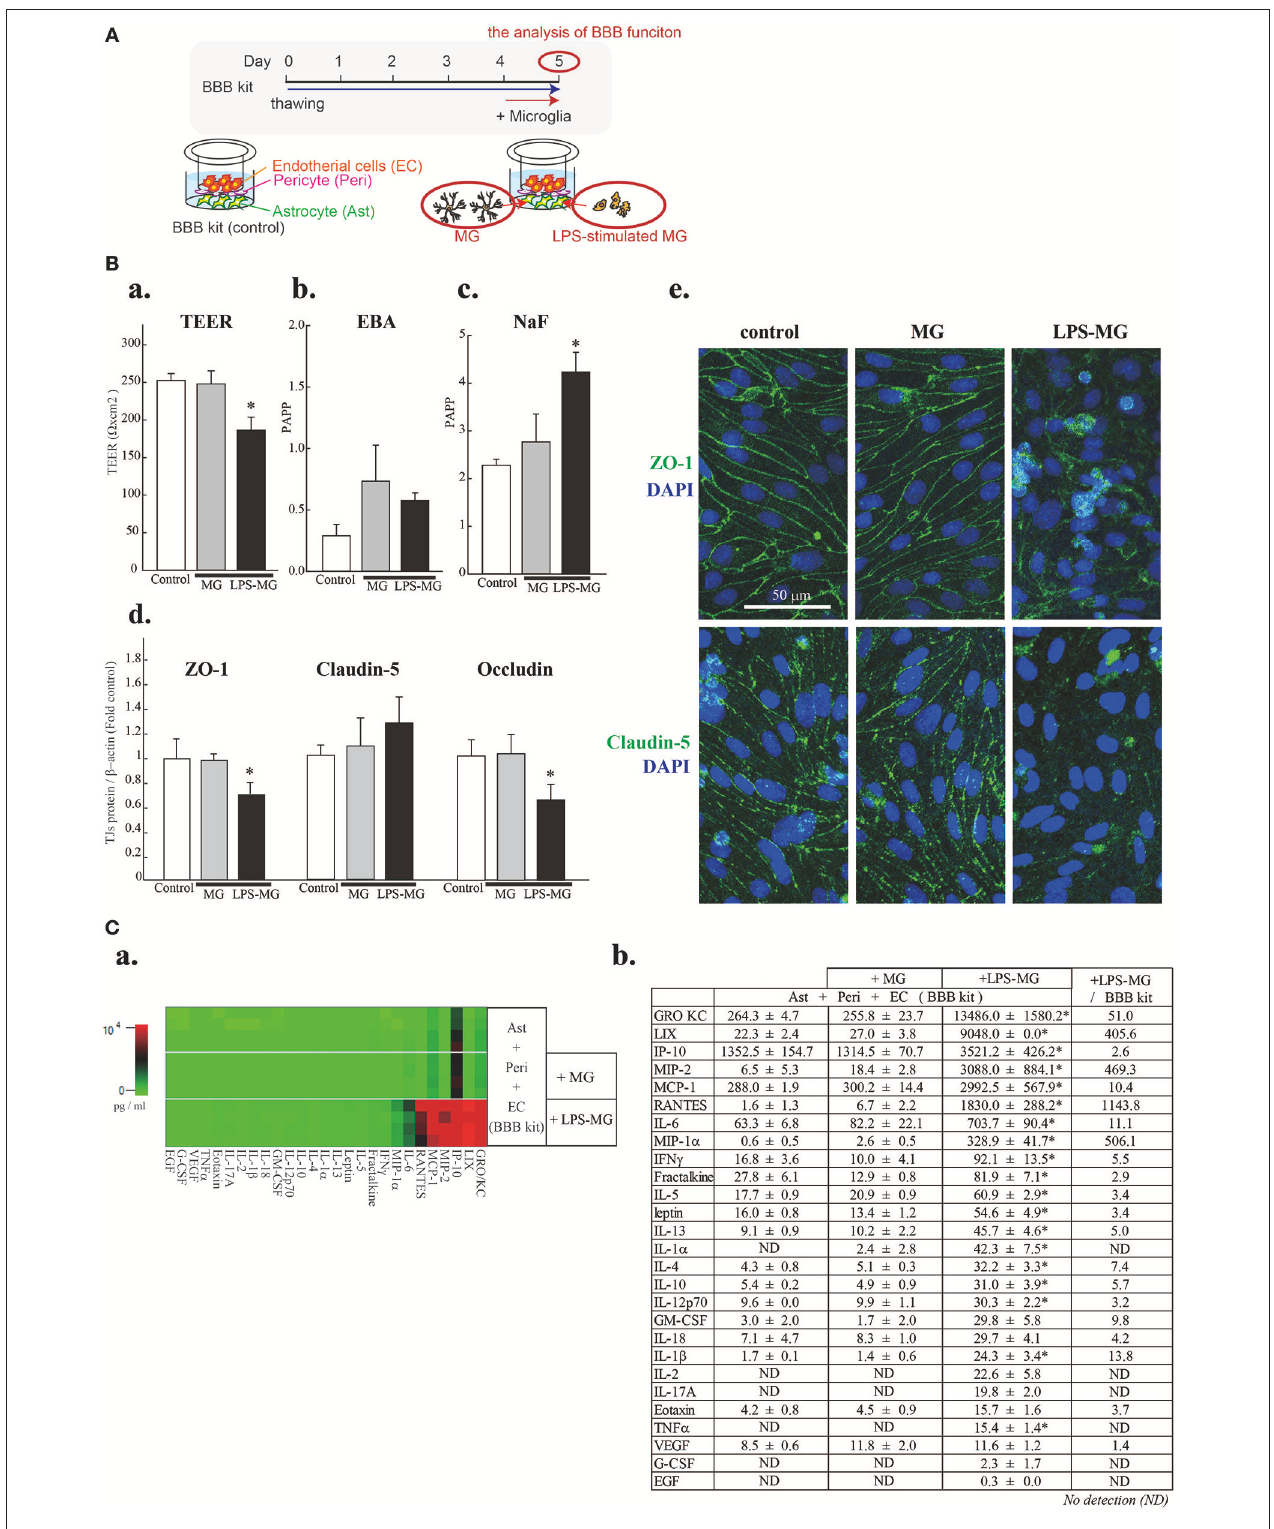
FIGURE 1 | Activated microglia disrupt BBB barrier functions and cause concentration changes of 19 C/Cs. (A) Schematic diagram of the experiment. (B) Effects of LPS-MG on TEER (a), and the permeability of EBA (b) and NaF (c). Effects of LPS-MG on the expression levels of TJ proteins (d). Immunocytochemistry of ZO-1